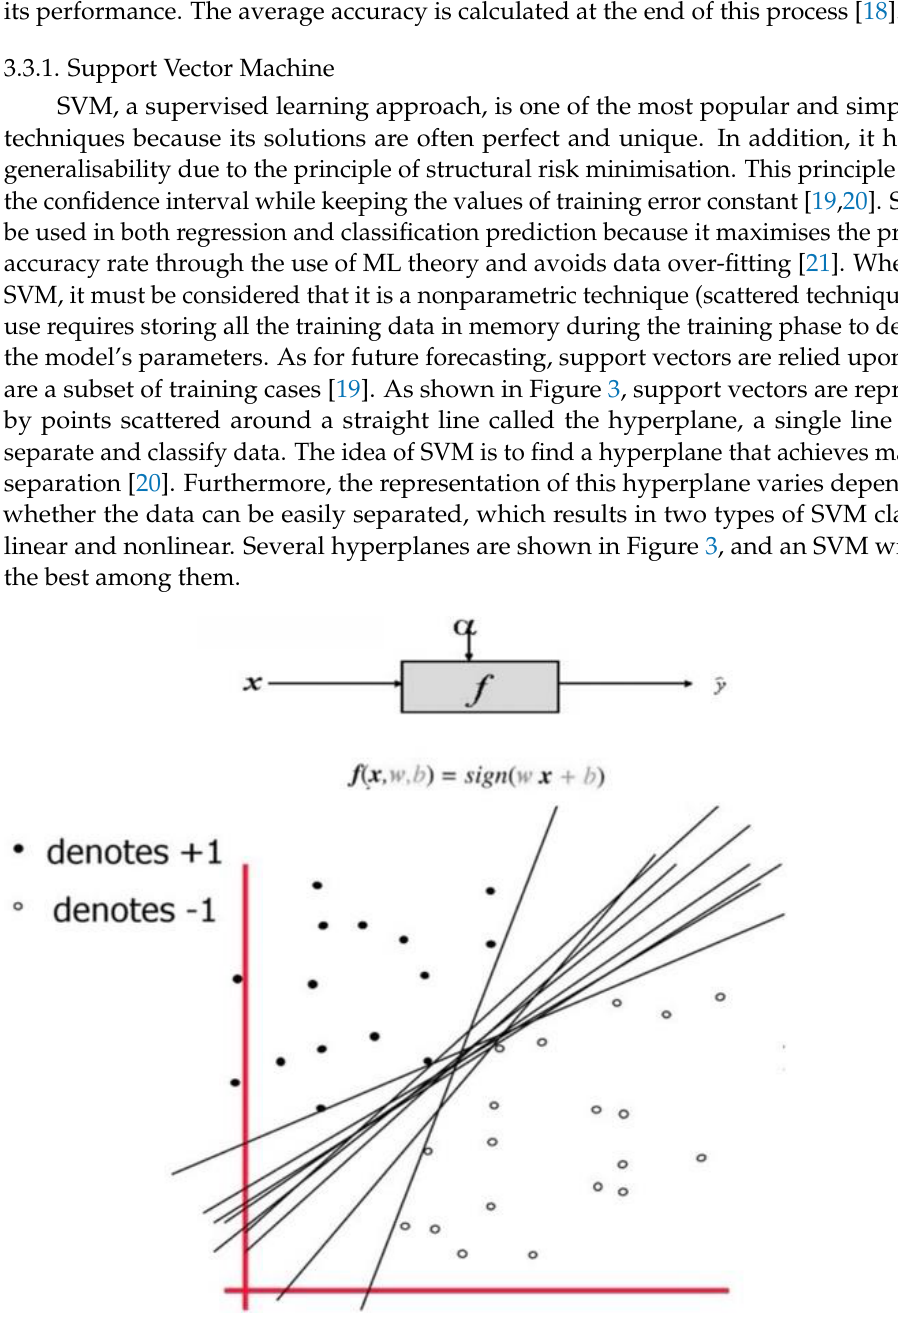
Figure 3. SVM classifier finding the best hyperplane between two classes.